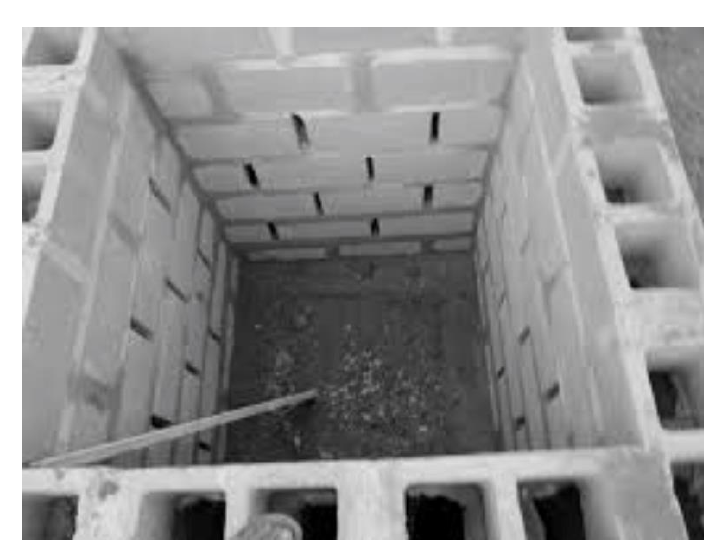
Fig. 1. A typical soakaway construction in